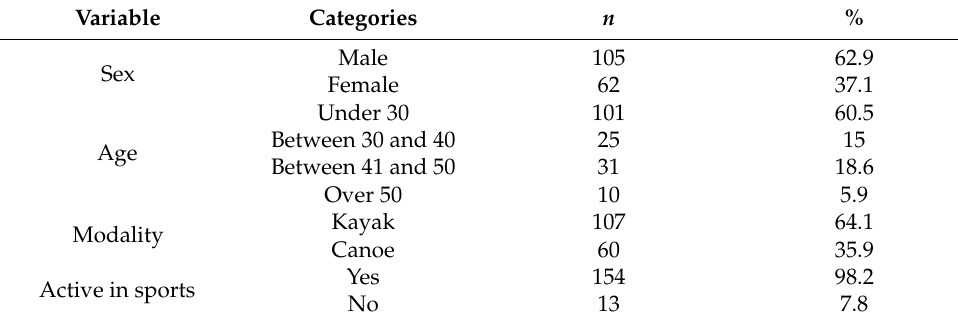
Table 1. Characteristics of the sample ( n =